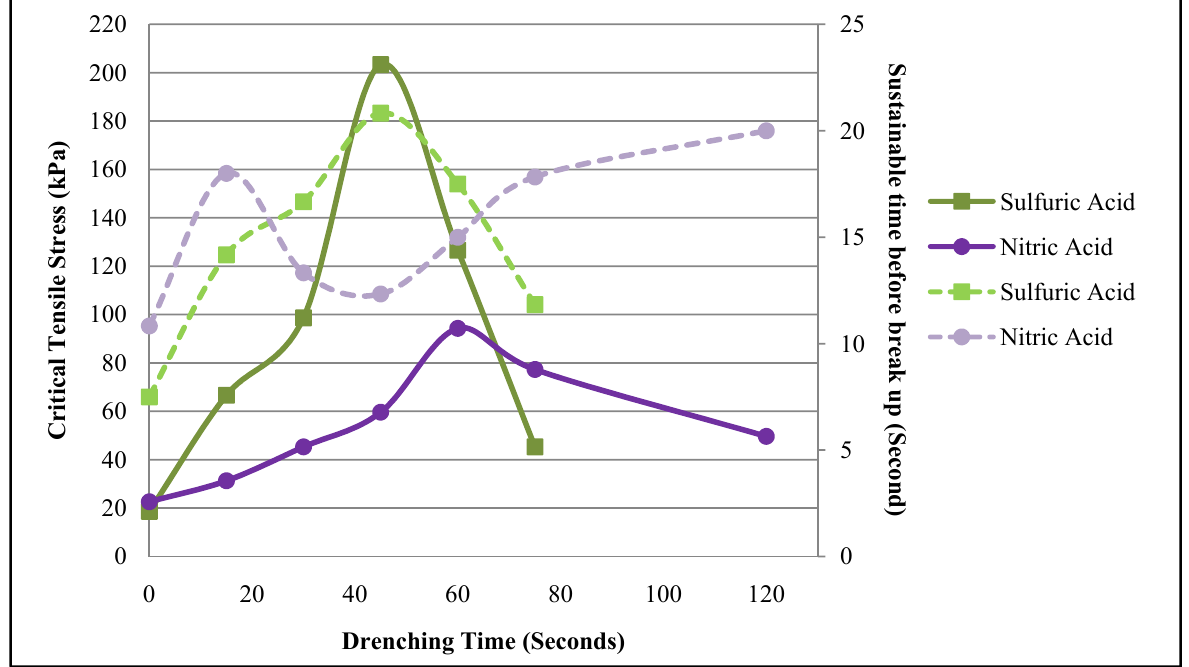
Figure 3. Critical Tensile Stress of bonding and its sustainable time against drenching time of PDMS pieces in sulfuric acid and nitric acid-based piranha solution respectively. Solid lines refer to the data of Critical Tensile Strength while the dotted lines refer to sustainable time before string